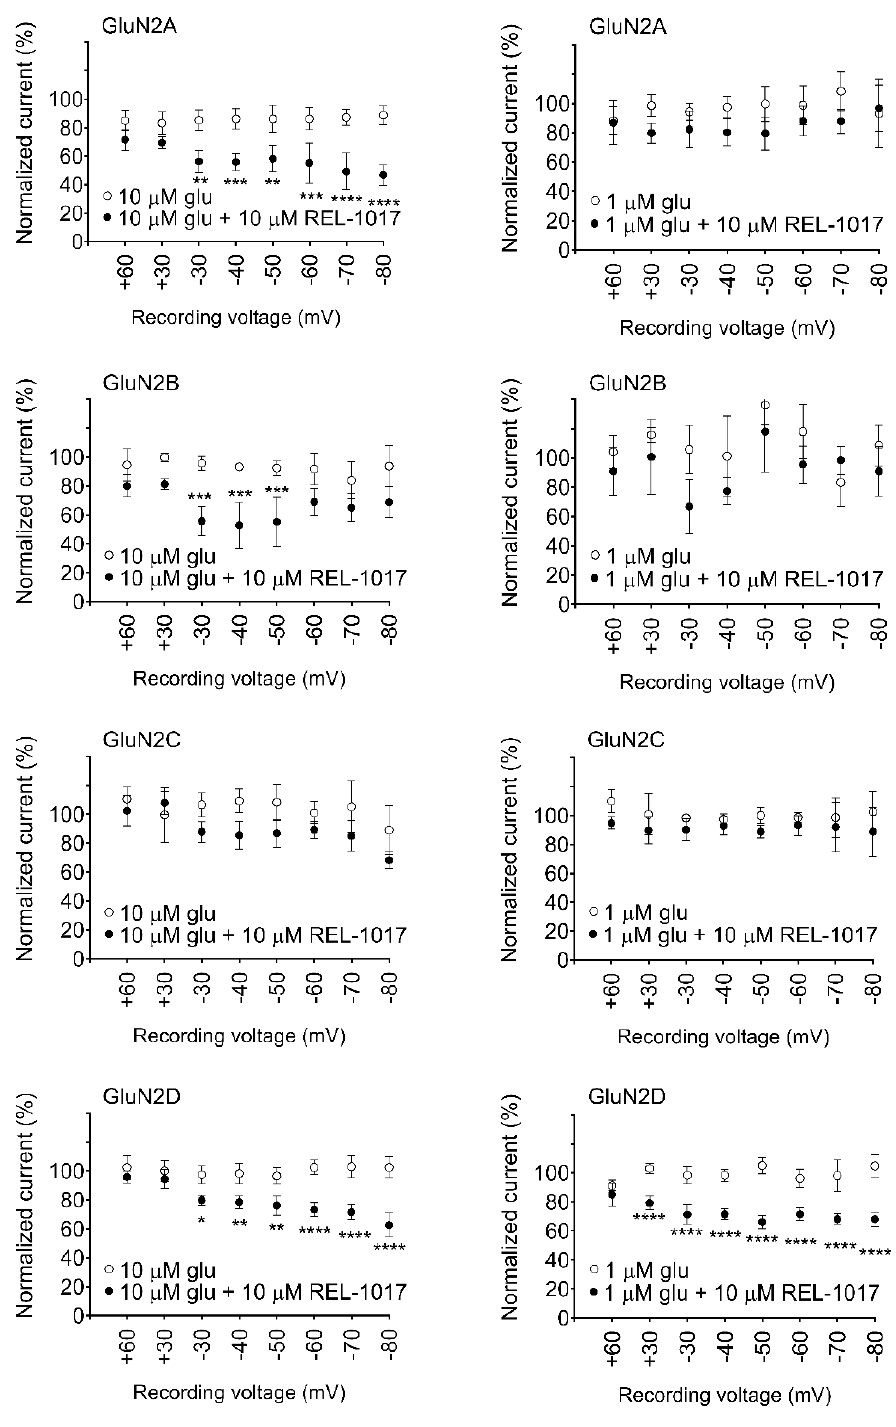
Figure 3. 10 µ M REL-1017 differentially blocked heterodimeric NMDARs in the presence of extracellular 1 mM Mg 2+ . REL-1017 showed a preference for NMDARs containing the 2D subunit, which is blocked in the presence of either 10 µ M or 1 µ M L-glutamate at − 30 mV or more negative voltages. Data were obtained in automated patch-clamp platform. Every data point represents mean ± SEM ( n = 4) of normalized current elicited by 10 mM L-glutamate at indicated voltage, measured during a hyperpolarizing ramp, in the absence ( ○ ) or presence (●) of 10 μM REL -1017. Statistical results of one-way analysis of variance (ANOVA) followed by Tukey’s multiple comparisons test also reported p < 0.05 (*), p < 0.01 (**), p < 0.001 (***), and p < 0.0001 (****). Glu is glutamate.